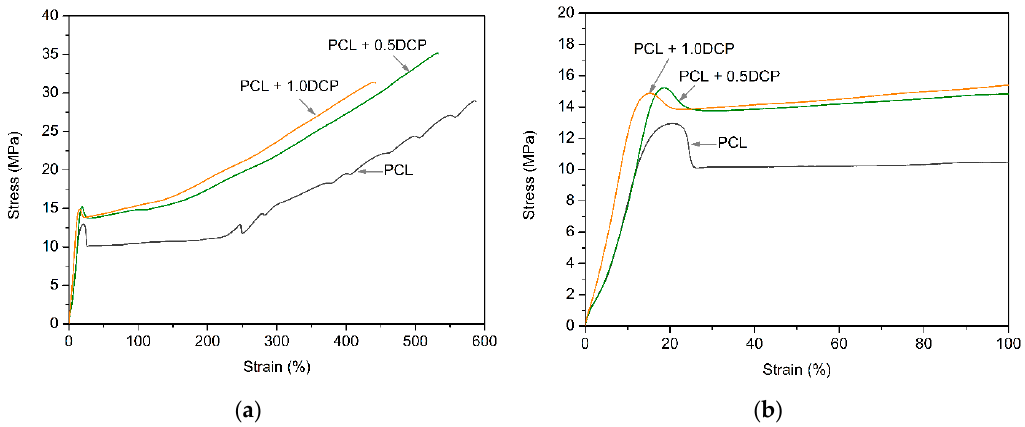
Figure 7. The stress–strain curves for PCL modified by DCP peroxide.